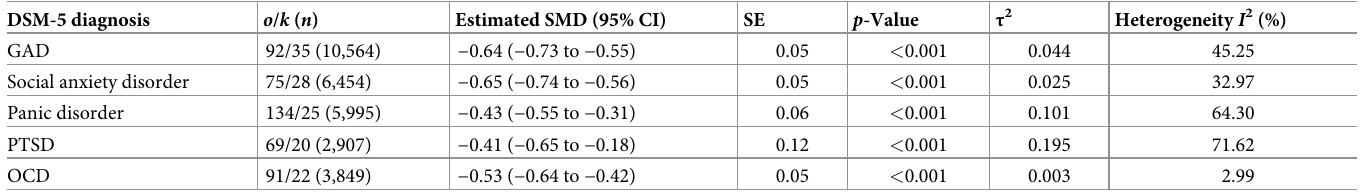
GAD, generalized anxiety disorder; k , number of studies; n , sample size; o , number of outcomes; OCD, obsessive-compulsive disorder; PTSD, post-traumatic stress disorder; SE, standard error; SMD, standardized mean